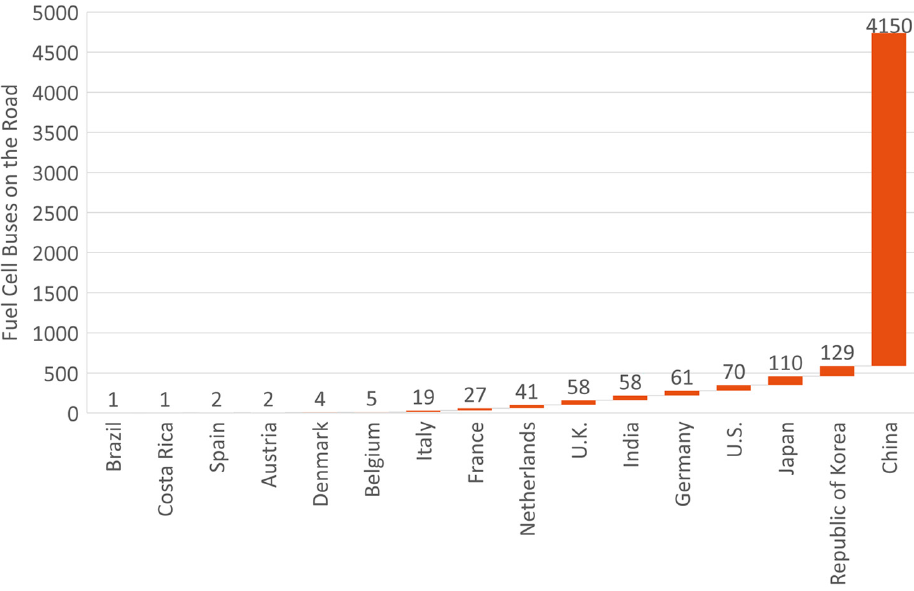
Figure 4. Waterfall diagram showing the breakdown of fuel cell buses (FCBs) worldwide.